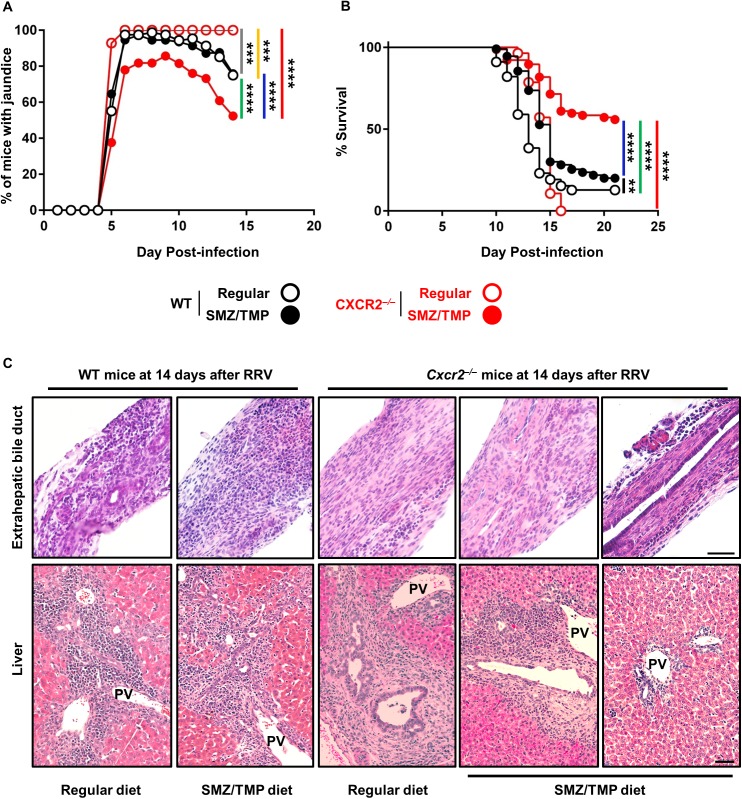
Clinical and tissue phenotypes in the SMZ/TMP-treated WT and Cxcr2-/- mice.(A) Development of jaundice and (B) survivability were examined following RRV-injection (N = 28–110 per group). Black bar: comparison between regular-WT and SMZ/TMP-WT; yellow bar: regular-WT and regular-Cxcr2-/-; green bar, regular-WT and SMZ/TMP- Cxcr2-/-; gray bar, SMZ/TMP-WT and regular-Cxcr2-/-; blue bar, SMZ/TMP-WT and SMZ/TMP-Cxcr2-/-. *, P<0.05; **, P<0.01; ***, P<0.001; ****, P<0.0001. (C) Longitudinal sections of EHBDs and liver sections stained with H&E from the SMZ/TMP-treated Cxcr2-/- mice. Unobstructed lumen and improved portal inflammation are observed in those Cxcr2-/- mice alive at 14 days after RRV-injection (N = 4–5 per group); magnified with x20 (bar = 50μm).